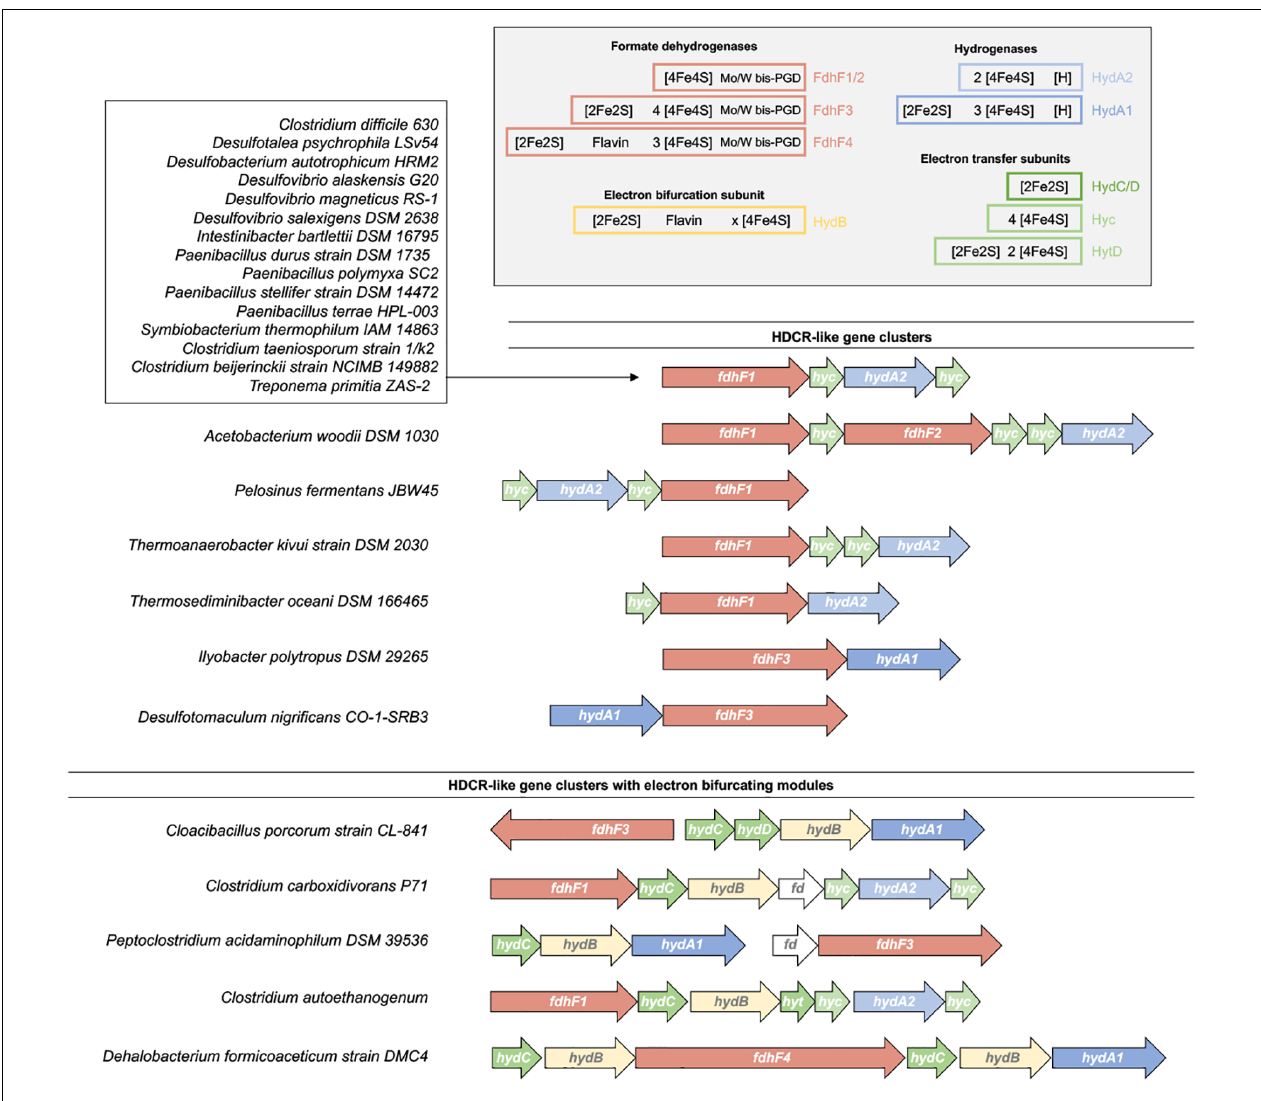
FIGURE 7 | Distribution of HDCR-like gene clusters. Fully sequenced bacterial genomes have been searched for HDCR-like gene clusters (Schwarz et al., 2018). Based on the gene cluster arrangement, the enzymes can be classified in HDCR-like enzyme complex without and with electron bifurcating modules. Predicted cofactors based on the primary sequence of each subunit are shown in the right top corner. For clarity, single genes disrupting the gene cluster in some organisms such as maturation genes (e.g., fdhD ) or transposase are not